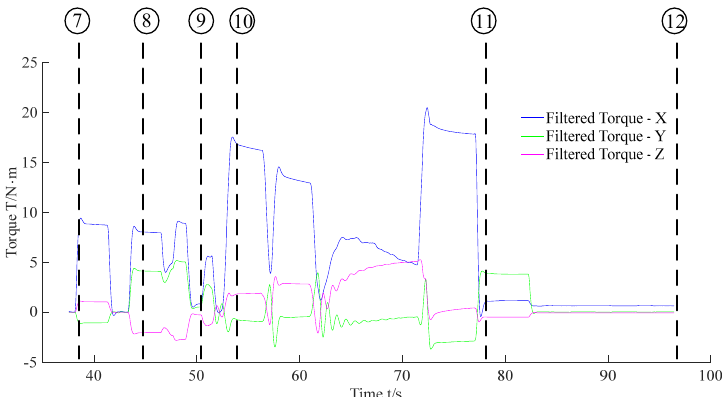
/ T location and the insertion assembly Figure 18. Feedback torque during the F/T location and the insertion assembly processes. Figure 18. Feedback torque during the F Figure 17. Feedback force during the F/T location and the insertion assembly processes.